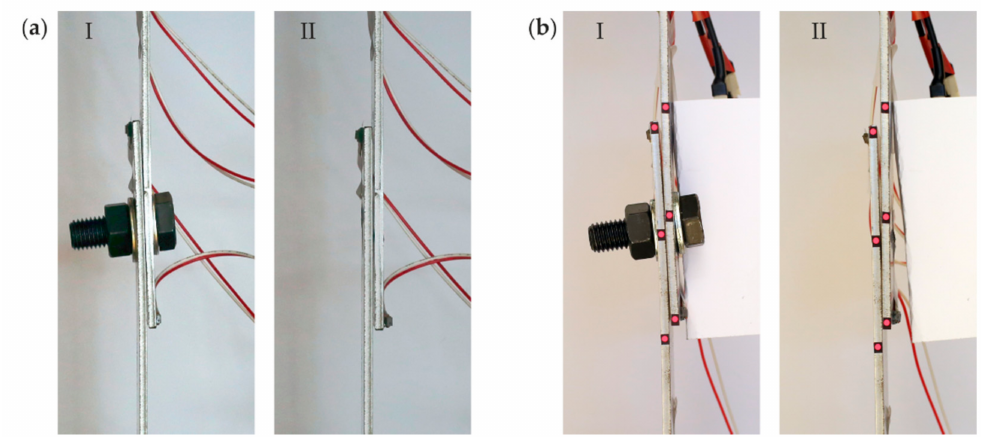
Figure 5. Bolted joints in the testing machine (I: the stage just before failure and II: the stage after failure): ( a ) specimen #1; and ( b ) specimen #2.